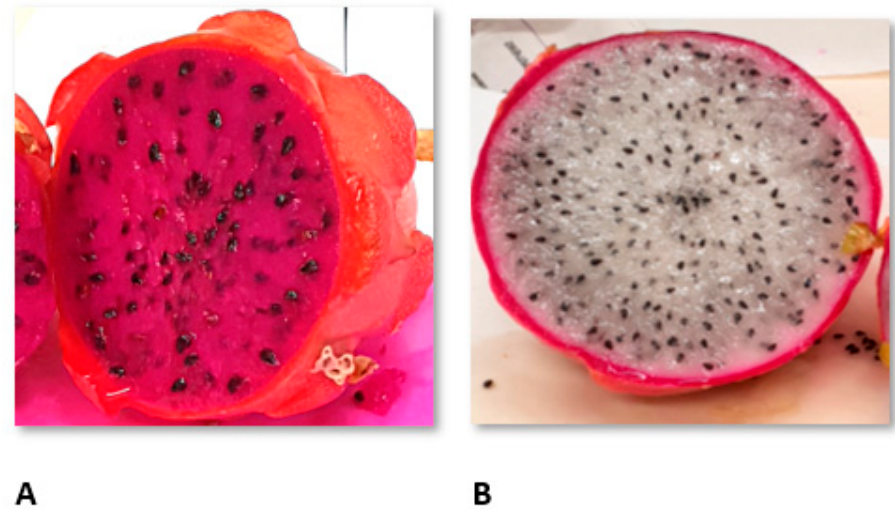
Figure 4. The example of evaluated dragon fruits: ( A ): H. costaricensis , with red skin and red flesh harvested in Israel and ( B ): H. undatus , with red skin and white flesh harvested in Thailand.